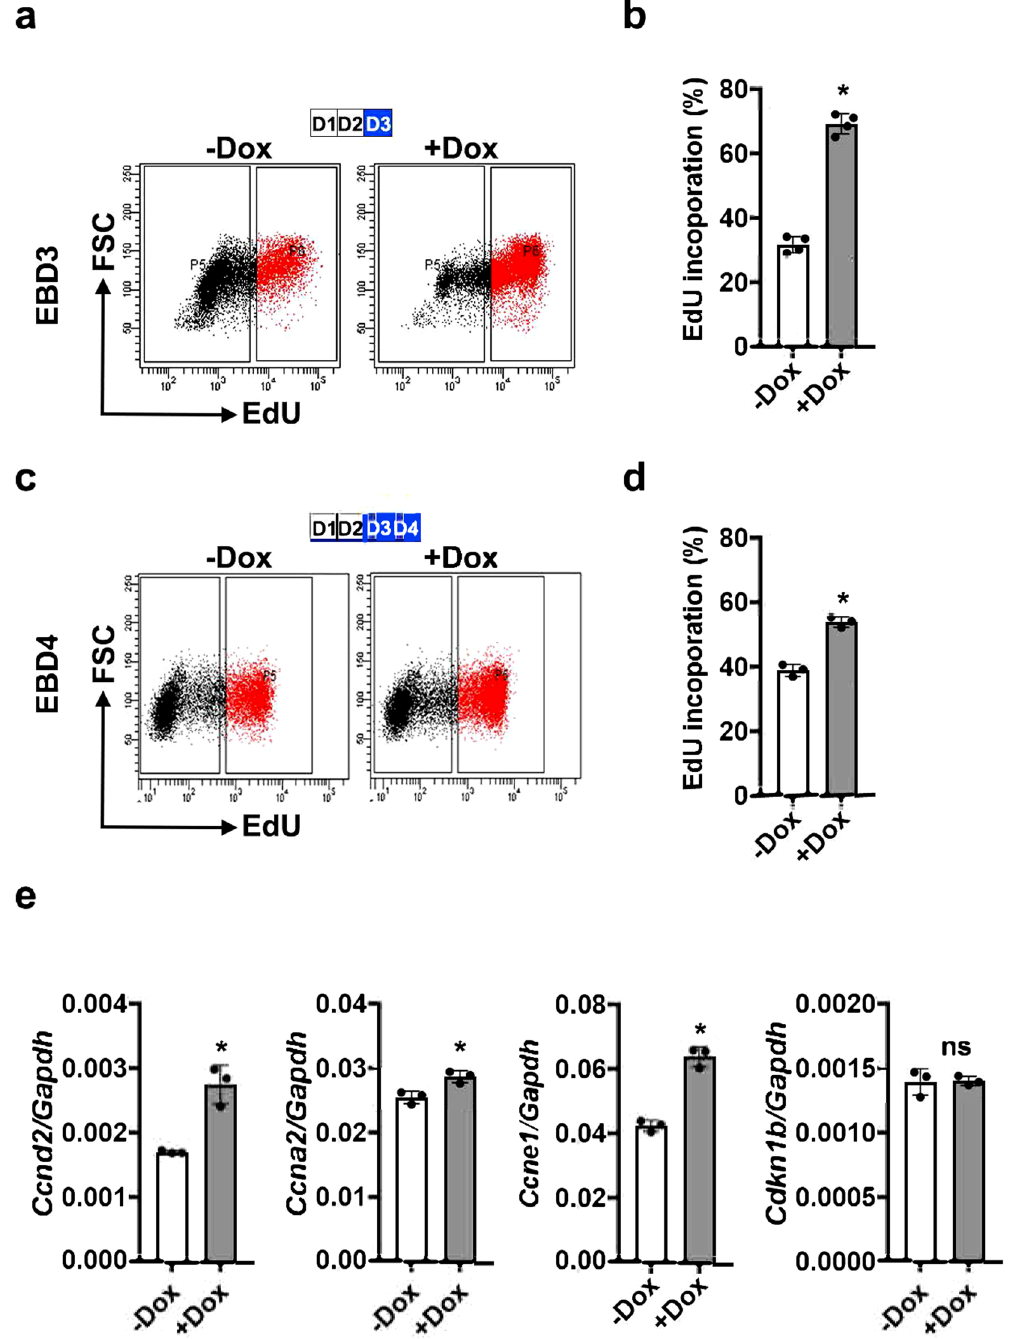
Figure 3. Induction of Etv2 promotes cellular proliferation in EBs. ( a – d ) FACS analysis ( a , c ) and quantification ( b , d ) of EdU-labelled cells from EBs in the absence ( − Dox) and presence ( + Dox) of Dox between D2-D3 and D2-D4. Dox induction of Etv2 resulted in significantly increased EdU labelling at both time points. Blue boxes indicate the timing of Dox treatment. ( e ) qPCR analysis of cell cycle gene expression in iHA - Etv2 ES/ EBs differentiated in the absence ( − Dox) and presence ( + Dox) of Dox. Pro-proliferative cell cycle genes Ccnd2 , Ccna2 and Ccne1 show increased expression with induction of Etv2. Expression of Cdkn1b , a cell cycle repressor, was not affected by Etv2 induction. Data are presented as mean ± SEM (n = 3 replicates; * p <